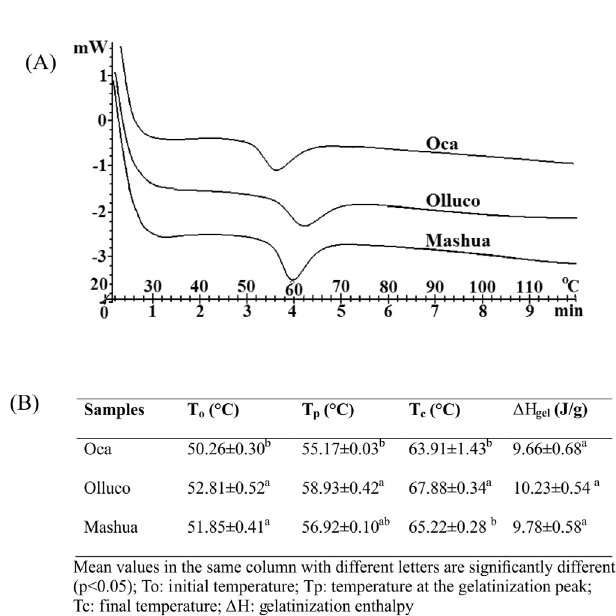
FIGURE 5. (A) Differential scanning calorimetry thermograms of oca, olluco and mashua starches heated with 70% water at a rate of 10 ºC/min; (B) Numeric data from the thermograms.